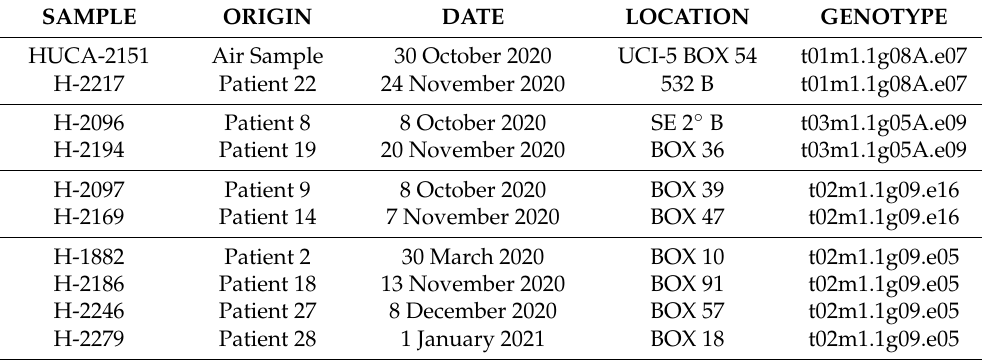
Table 3. A. fumigatus isolates with the same TRESPERg